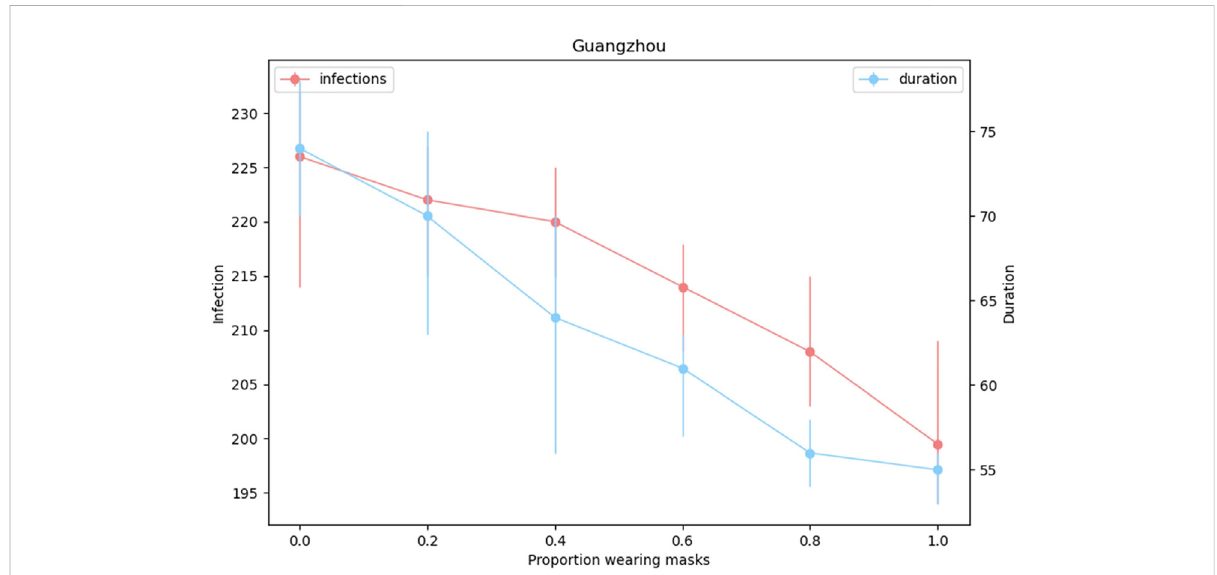
FIGURE 10 Effectofdifferentproportionsofmaskuse.Wetakethetotalnumberofinfectionsandthedurationoftheepidemicasanevaluationindex.Blue curve indicates the predictions of epidemic duration and red curve is the cumulative infections. The error bars indicate the 95% CI for model